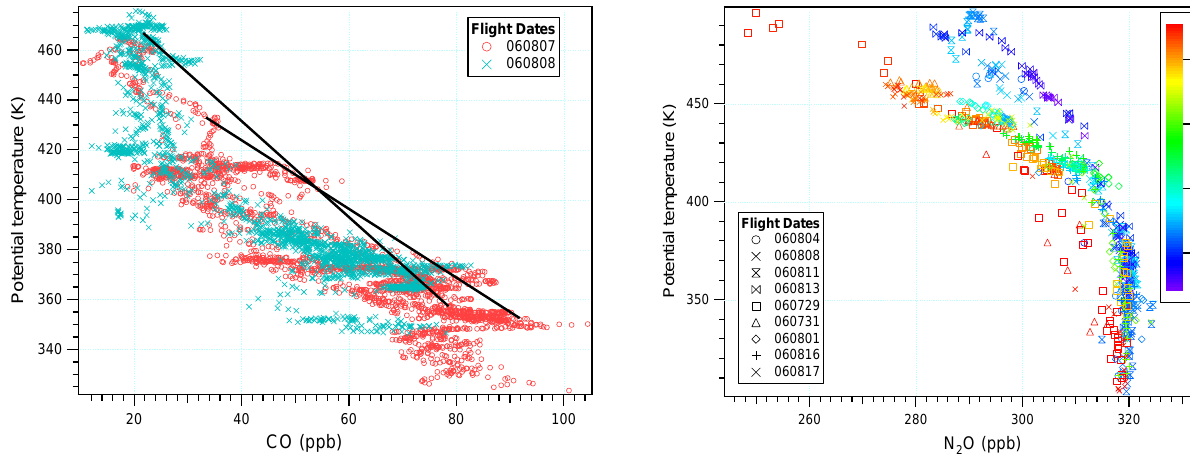
Fig. 7. Vertical profile of N 2 O coloured to